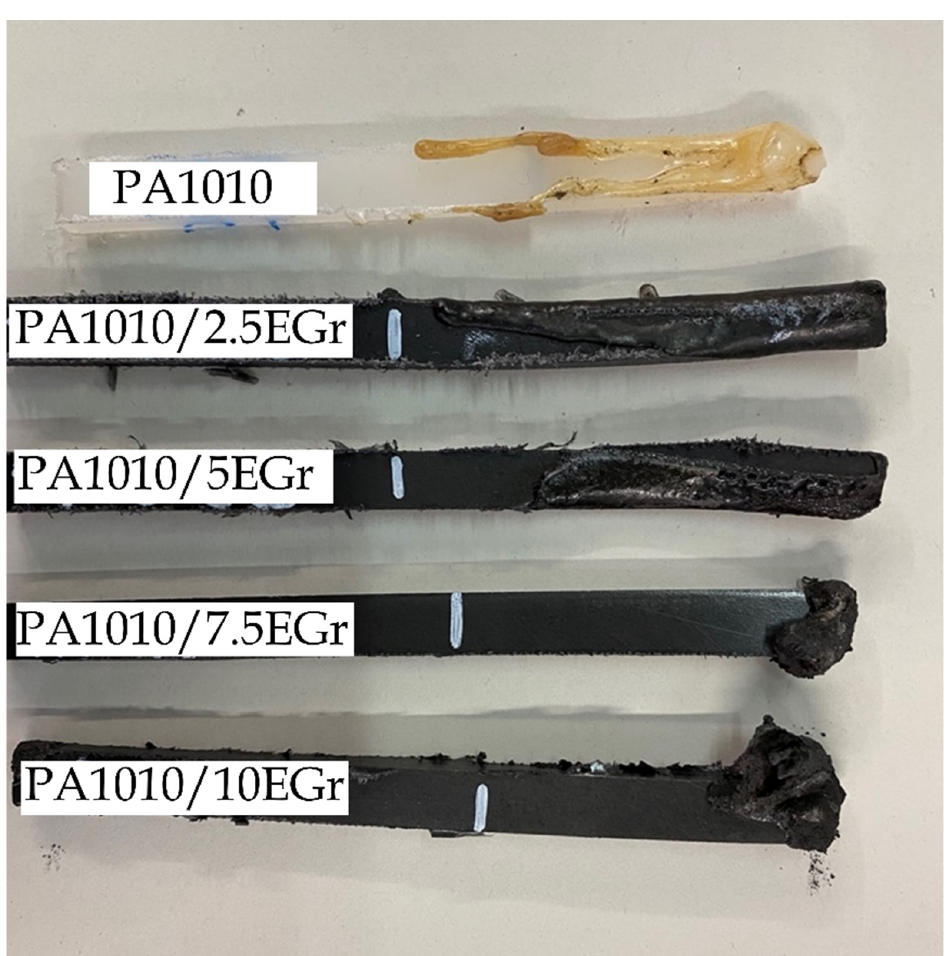
Figure 10. Visual appearance of the samples after UL-94 test.